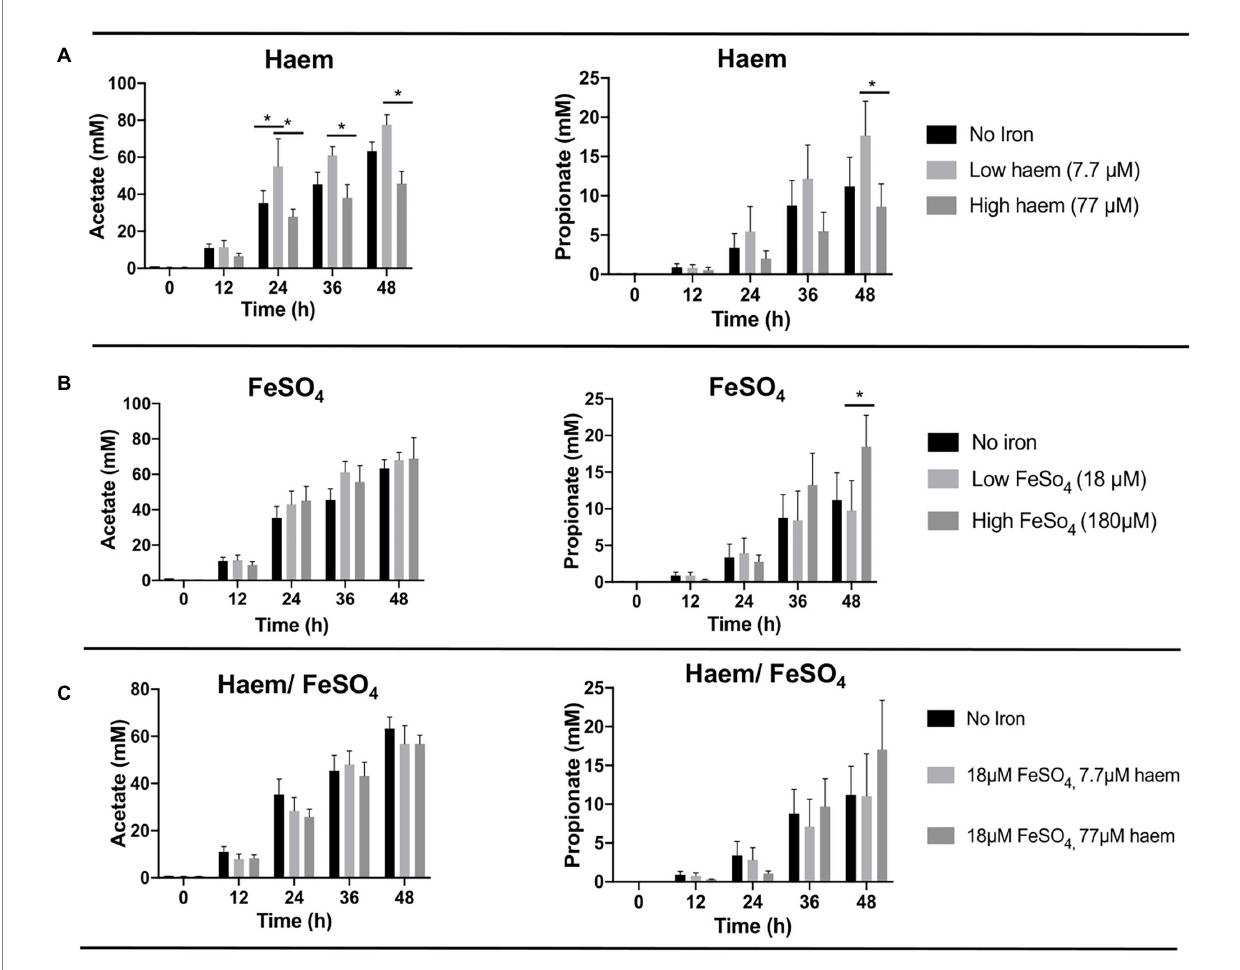
FIGURE 4 Acetate and propionate production from fermentation in single-stage anaerobic batch culture using different forms and concentrations of iron. (A) Haem, (B) FeSO 4 and (C) combination of haem and FeSO 4 . Values are mean values of fermentations from 3 different healthy donors. Technical duplicates were performed for each condition in every fermenter. Significant differences ( p < 0.05) among treatments at the same time point are denotated with an